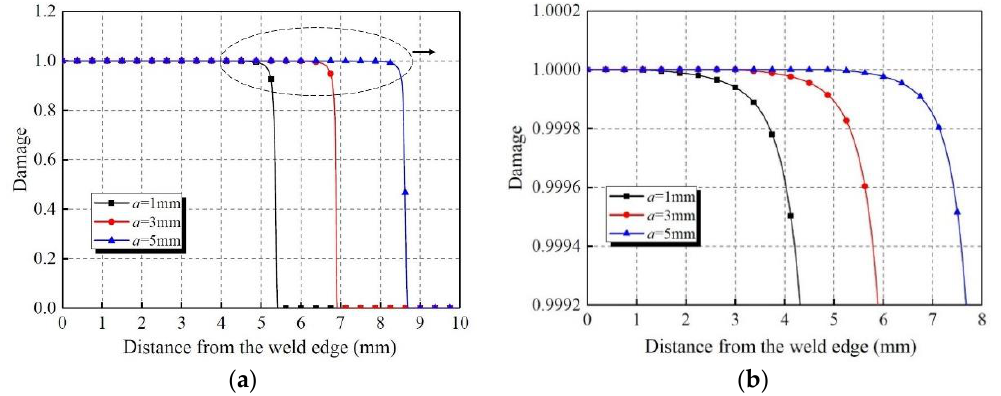
Figure 14. Stress distribution of the brazed joint with different crack lengths: ( a ) a = 0 mm, ( b ) a = 1 mm, ( c ) a = 3 mm, and ( d ) a = 5 mm.